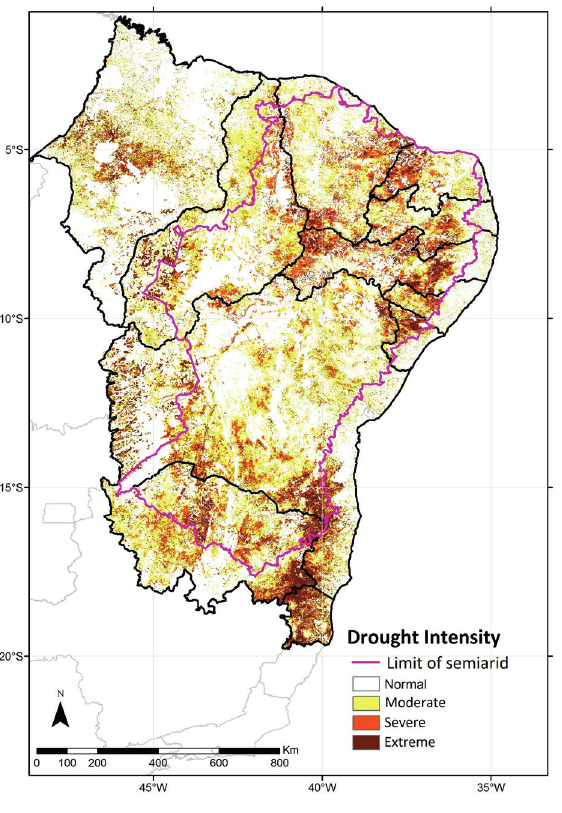
Figure 6 - Municipality area percentage affected by drought according to VSWI anomaly percentage for hydrological year 2015−2016.